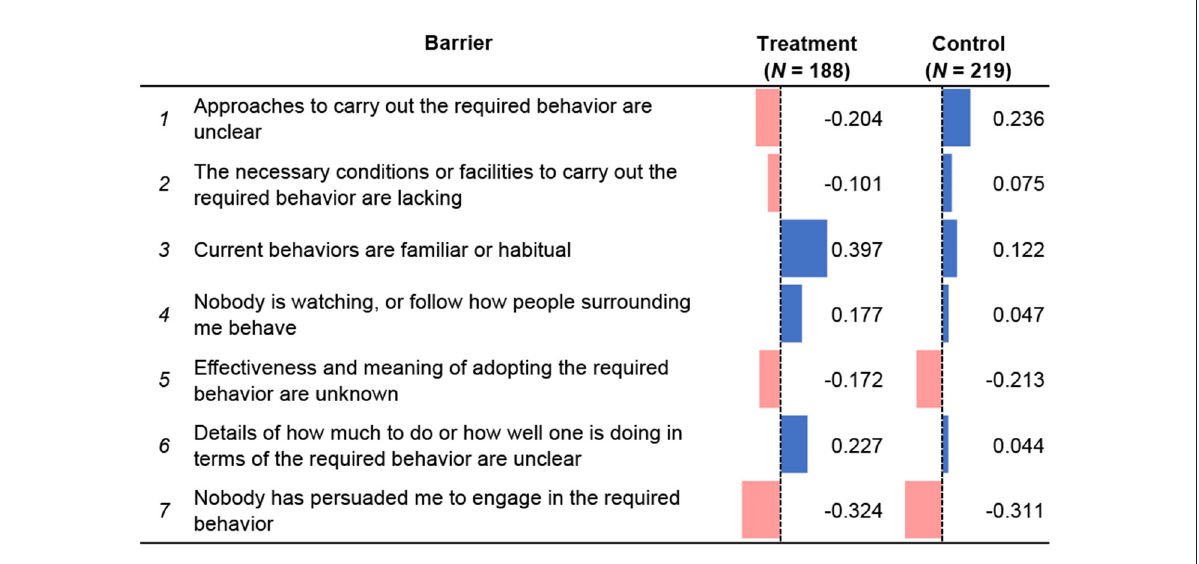
FIGURE2 Standardized BW scores comparing between treatment and control